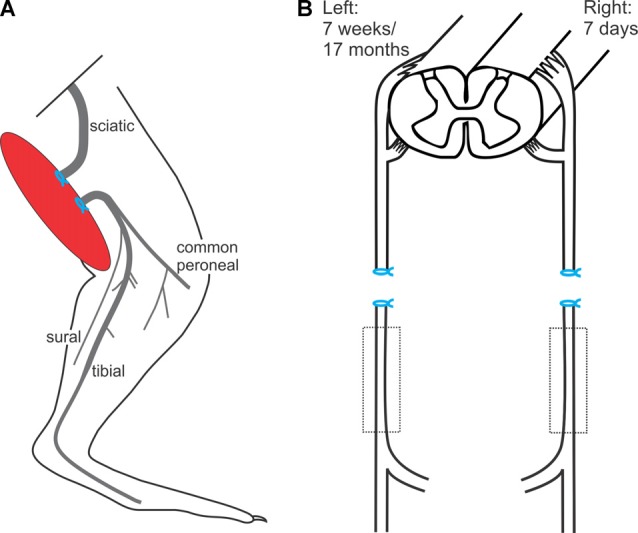
In vivo sciatic nerve transection and ligation to denervate Schwann cells (SCs) in the distal nerve stump. (A) Under surgical anesthesia and using aseptic precautions, the left sciatic nerve was exposed, cut, and the proximal and distal nerve stumps ligated and sutured to nearby innervated muscles to prevent axonal regeneration and reconnection for 7 weeks or for 17 months, the experimental groups of chronic distal nerve denervation in the left hindlimb. (B) In a second aseptic surgery, 7 weeks or 17 months later, the rats were again anesthetized and the right sciatic nerve was cut and ligated and again, the nerve stumps were sutured to innervated muscle in order to prevent regeneration for 7 days.